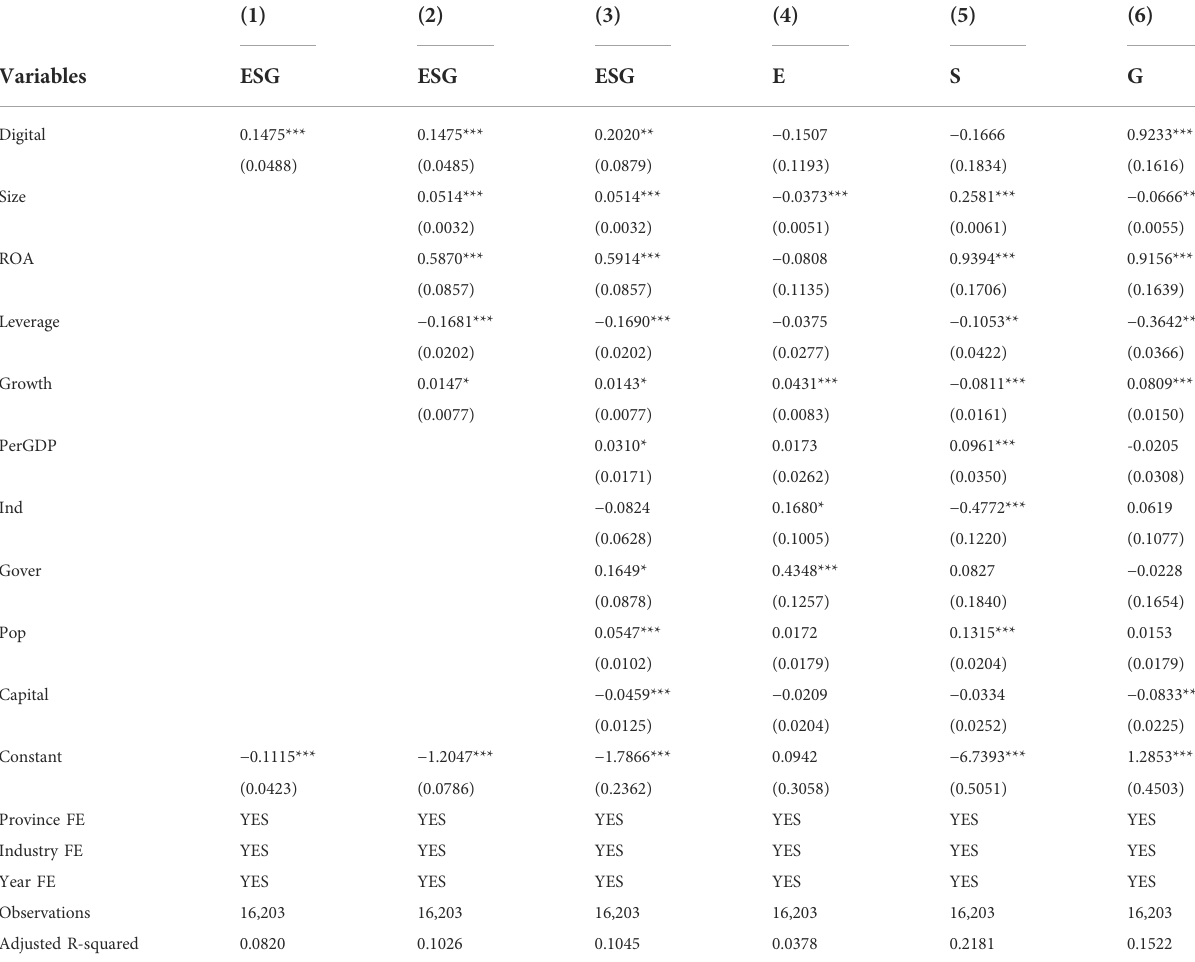
TABLE 3 Regression results of the impact of urban digital economy development on enterprise ESG